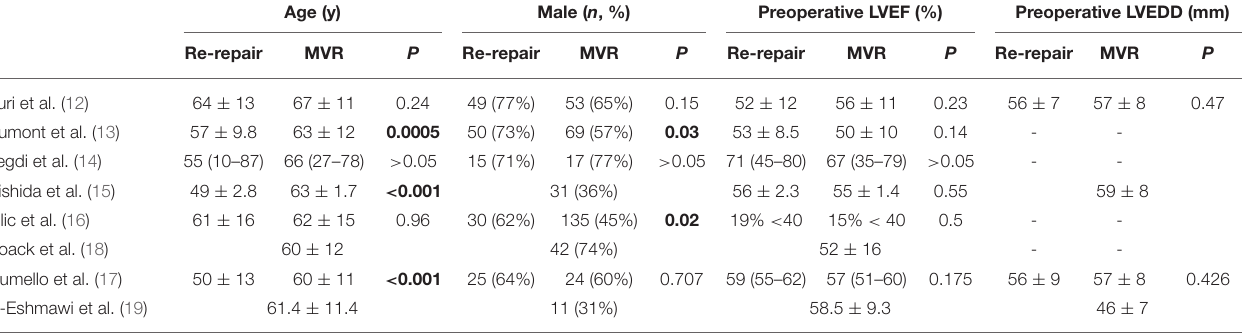
TABLE 2 | Baseline demographic